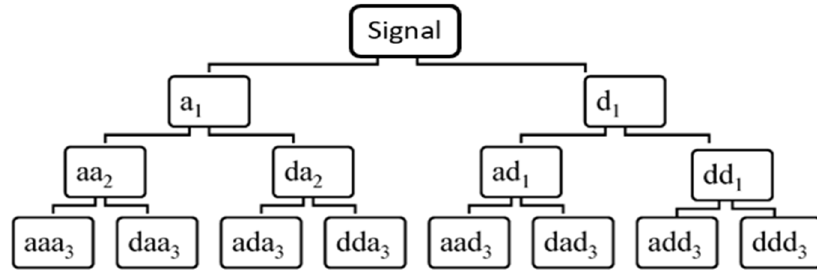
Figure 1. Three level WPT subbands of a sample current signal of an induction motor.